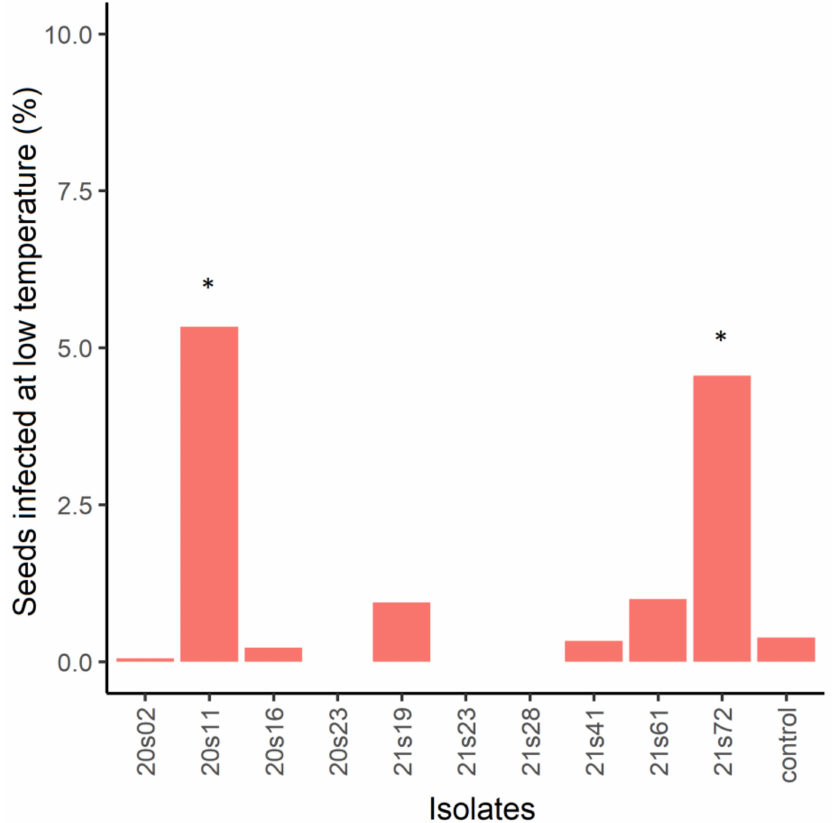
Figure 5. Average number of seeds with signs of Fusarium infection after 14 days at 10 ◦ C. Non- inoculated seeds were used as a control. Asterisk (*) denotes treatments where the number of intact seeds at the end of experiment was significantly different from the control